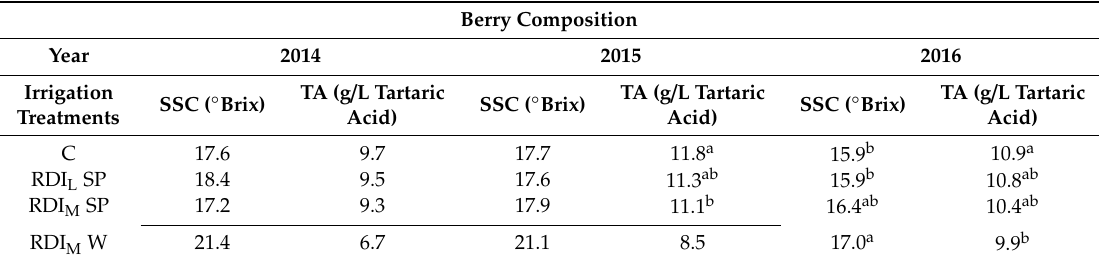
Table 3. Mean values of the berry composition parameters for each irrigation treatment in the 2014, 2015, and 2016 growing